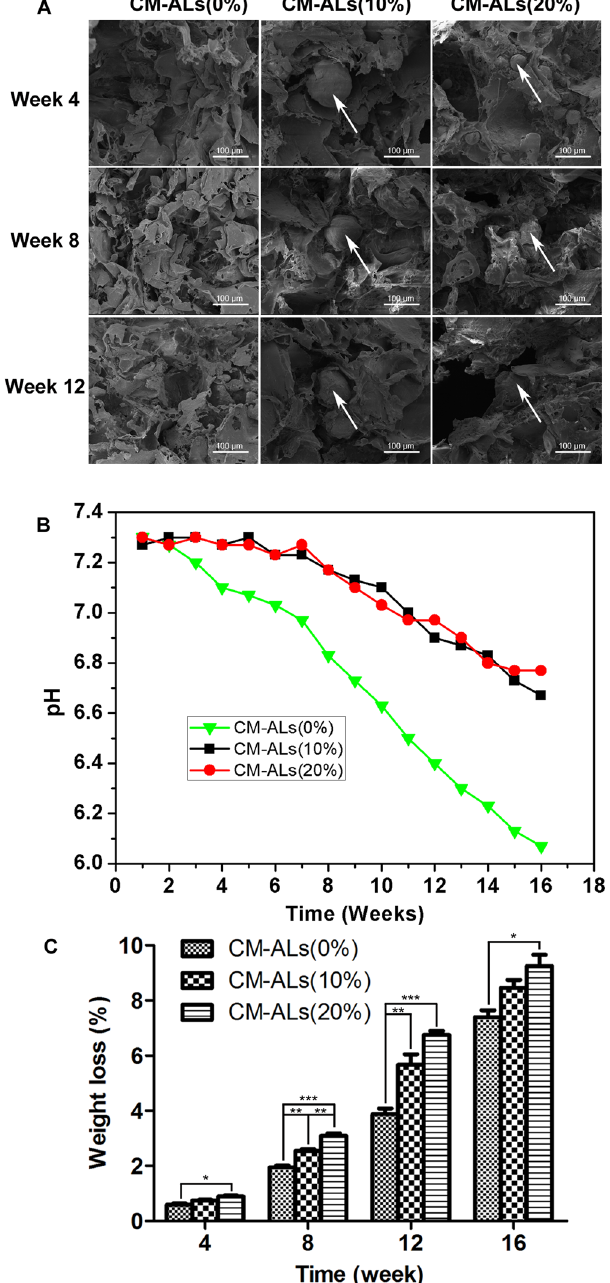
Figure 2. In vitro degradation of the CM-ALs scaffolds with different CH/nHA-AL contents during the 12 weeks of observation. ( A ) Morphological changes of the scaffolds observed under SEM; ( B ) pH value of degradation medium from the prepared scaffolds with the increasing incubation time; ( C ) Mass loss of the scaffolds during the degradation period. White arrow indicates CH/nHA-AL microsphers. * p < 0.05, ** p < 0.01, *** p < 0.001 vs CM-ALs (0%) or CM-ALs (10%)